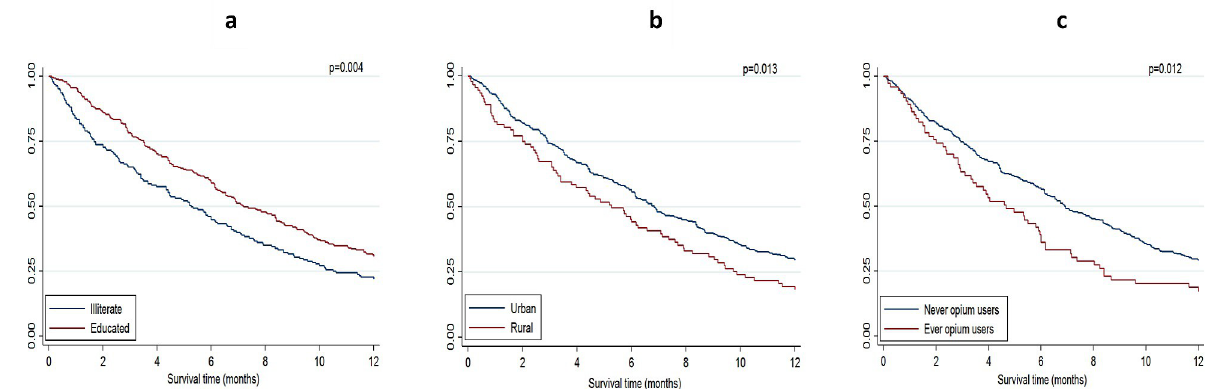
Fig 1. Overall survival during the first 12 months of diagnosis in Iranian patients with pancreatic ductal adenocarcinoma. The survival curves are stratified by a. having formal education, b. residence, c. ever use of opium.